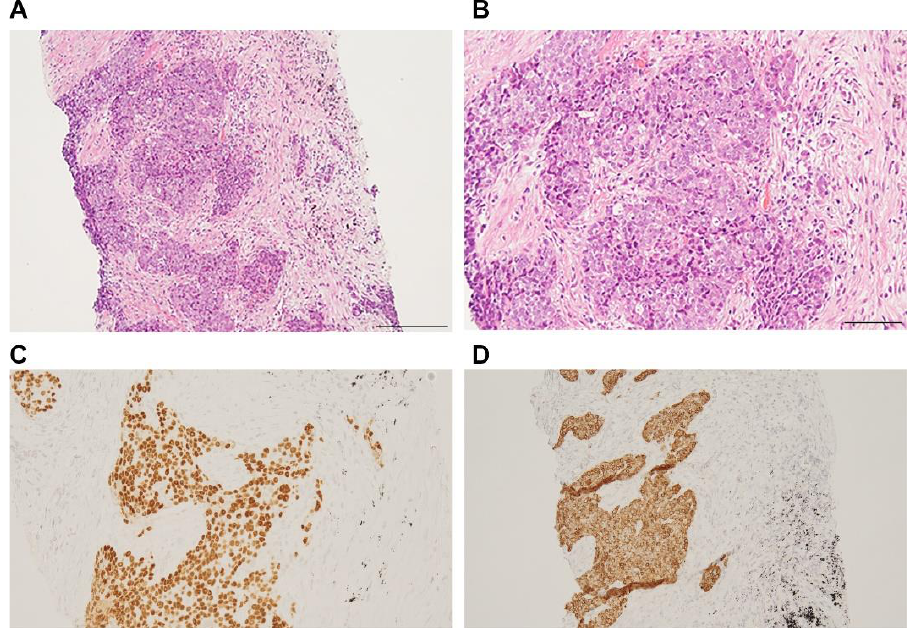
Figure 3. Tumor pathological findings. Hematoxylin/eosin staining of the tissue specimen revealed a solid tumor with interstitial fibrosis ( A , B ) and positive immunostaining for p40 ( C ) and CK5/6 ( D ). Scale bars indicate 200 µm ( A ) and 80 µm ( B ).